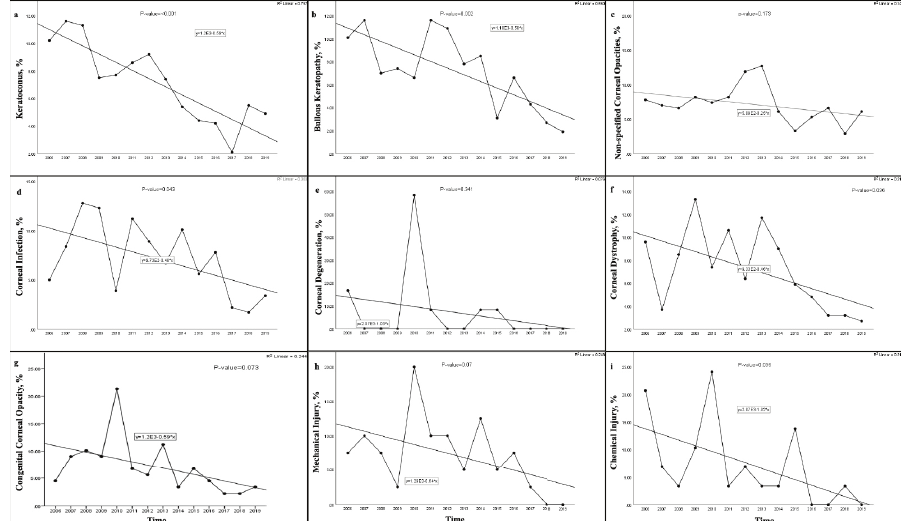
Figure 2. Trends of the indications for pediatric keratoplasty in each main category in Iran between 2006 and 2019. Note the significant declining trend for keratoconus (a; P < 0.001); bullous keratopathies (b; P = 0.002); corneal infections (d; P = 0.043); corneal dystrophies (f; P = 0.036); and chemical injuries (i; P = 0.036). No significant change of trend is noted for non-specified corneal opacities (c; P = 0.173), corneal degenerations (e; P = 0.341), congenital corneal opacities (g; P = 0.073), and mechanical injuries (h; P = 0.07) over the 14-year